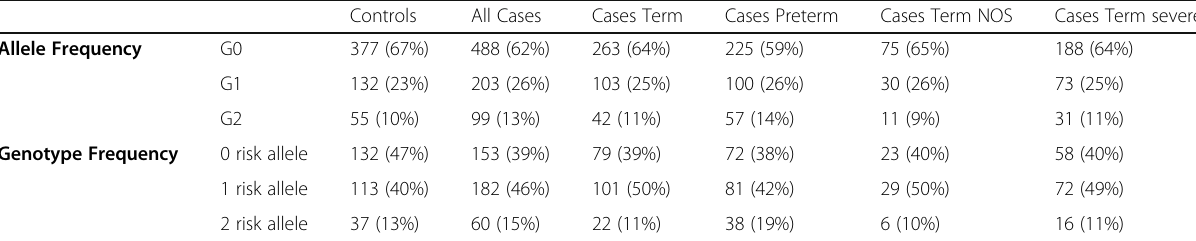
Table 2 APOL1 alleles and genotype frequencies